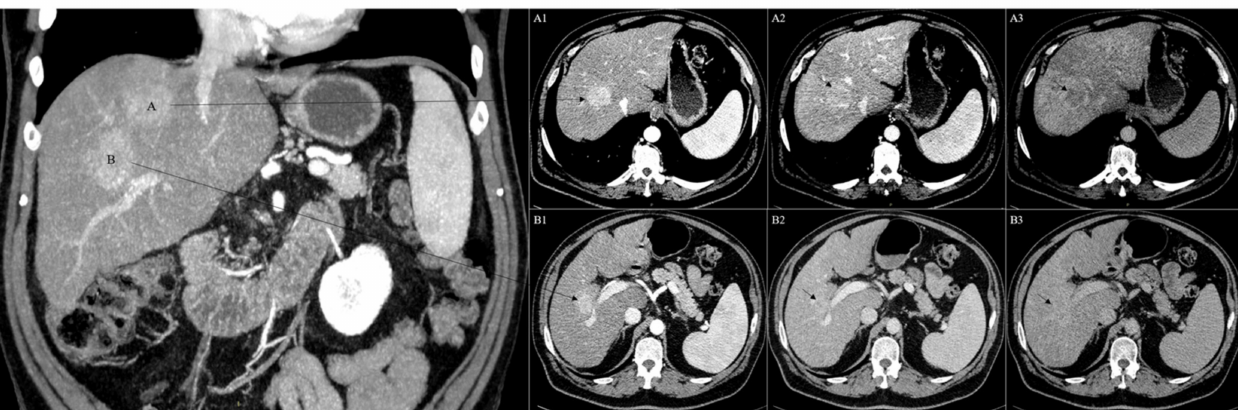
Figure 3. CT of two synchronous and separate epicenters of histologically confirmed hepatocellular carcinoma and combined hepatocellular cholangiocarcinoma in the same liver ( A , B ). In particular, the hepatocellular carcinoma was located in the segment VIII of the liver and presented an arterial phase hyperenhancement ( A1 ), followed by an initial wash-out during the portal phase ( A2 ), which became more evident during the late delayed phase ( A3 ). On the contrary, the combined hepatocellular cholangiocarcinoma was located in the segment VI of the liver and showed a strong hyperenhancement during the arterial phase ( B1 ), followed by a persistent enhancement during the portal phase ( B2 ) and no wash-out during the late delayed phase ( B3